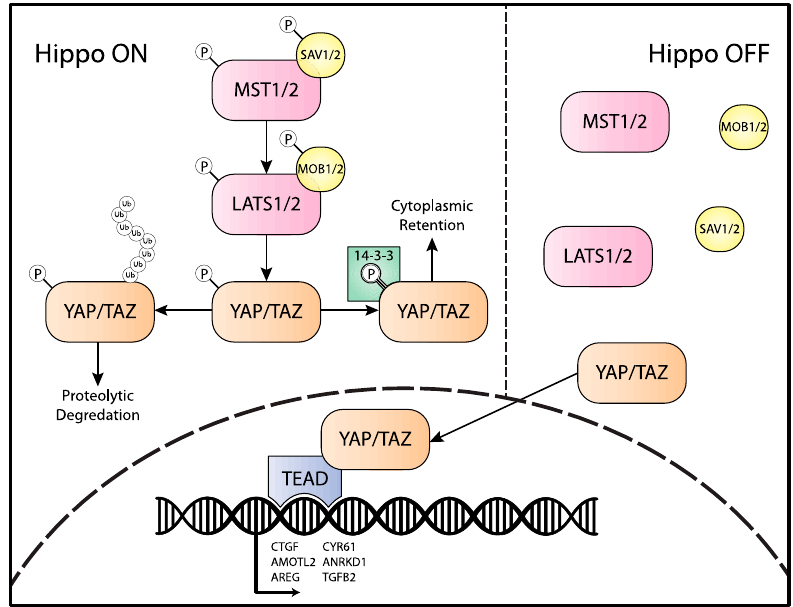
Figure 1. Schematic of the Hippo pathway. The top left represents the activation of the Hippo pathway with phosphorylated core Hippo kinases and YAP/TAZ. Phosphorylated YAP/TAZ leads to cytoplasmic retention via binding to 14-3-3 proteins and/or polyubiquitination and proteolytic degradation. Upon Hippo inactivation (top right), YAP/TAZ can migrate to the nucleus, where it can bind to its TEAD cofactors and activate transcription.